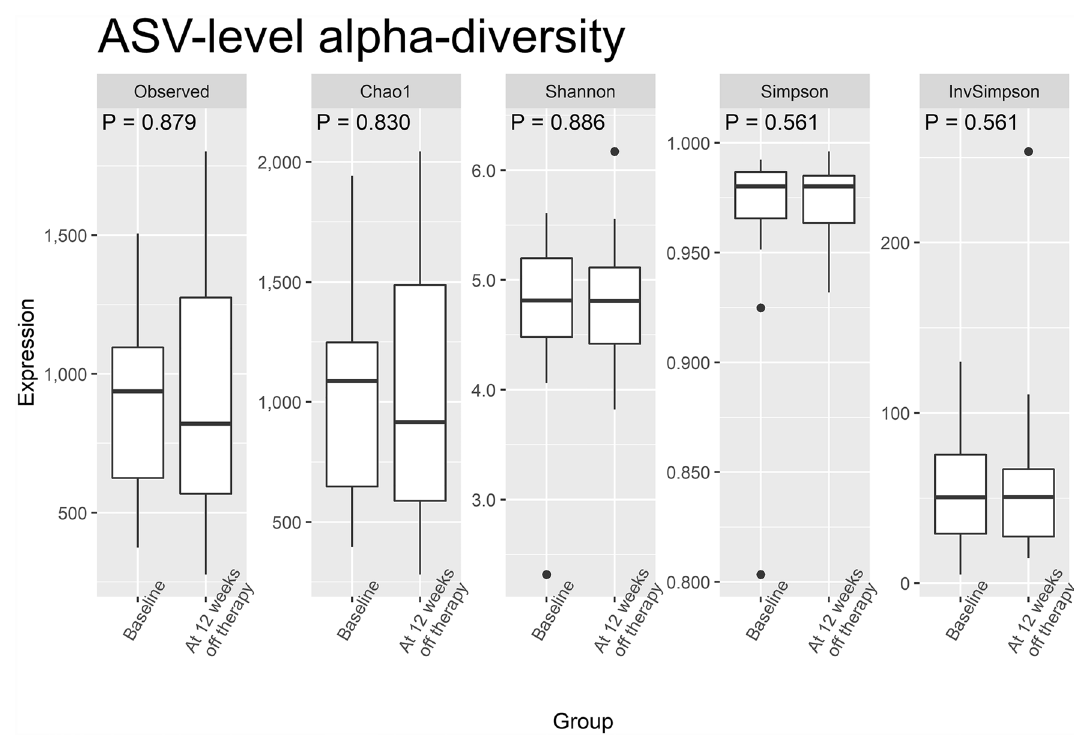
Figure 3. Metrics of alpha diversity for gut microbiome at baseline and 12 weeks following eradication of hepatitis C virus